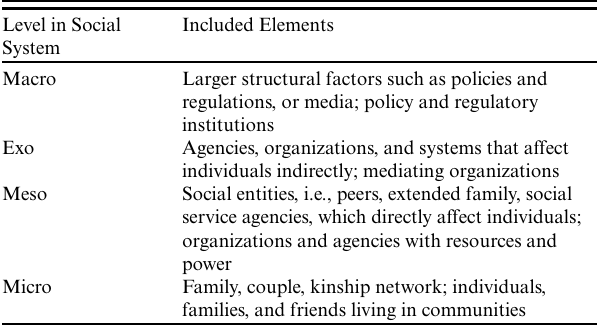
Table 1 . Levels of influence within social systems (from Schensul 2009).